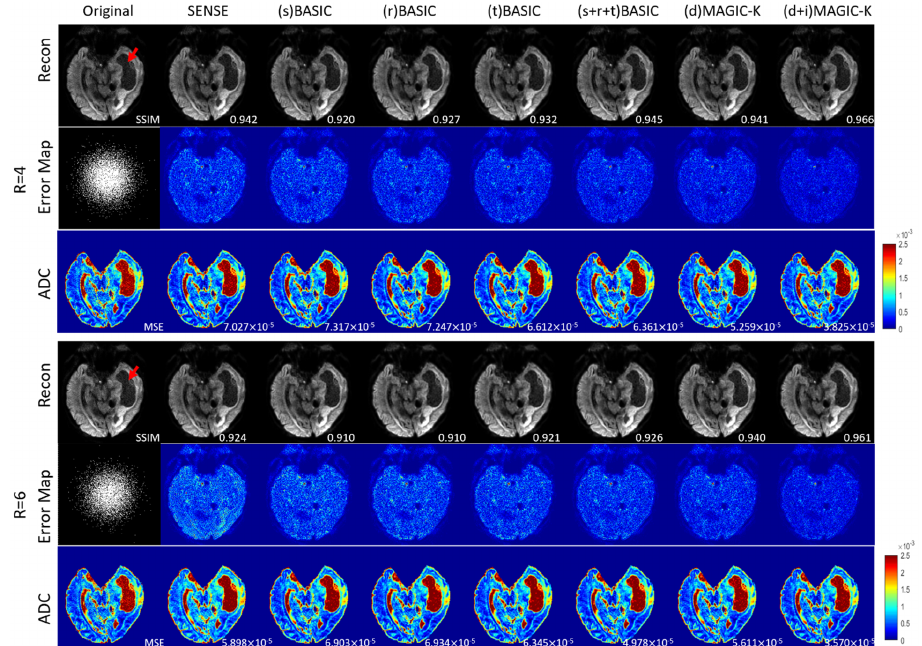
Figure 9. Comparison of the reconstructed images by different image augmentation strategies using variable density undersampling in a tumor patient with glioblastoma. The SSIM is listed at the bottom-right of each reconstructed image. The error map was ×10 amplified for better visualization. The MSE is listed at the bottom-right of each ADC map. Aliasing artifacts are depicted by the yellow arrows. The edema is depicted by a red arrow.